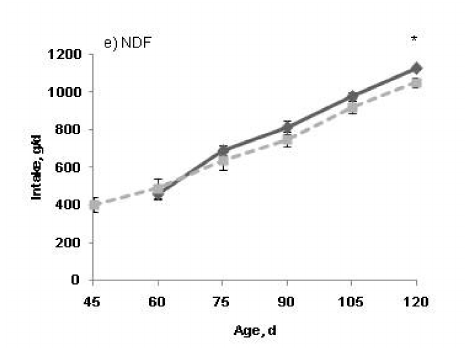
Figure 2. Intake of concentrate feed ( a ); forage mixture ( b ); total dry matter (DM, ( c )); crude protein (CP, ( d )); and neutral detergent fiber (NDF, ( e )); at di ff erent ages of the growing lambs after weaning. Dashed line, lambs weaned at d 30 (W30); Solid line, lambs weaned at d 45 (W45). Error bars indicate SE. * p < 0.05.